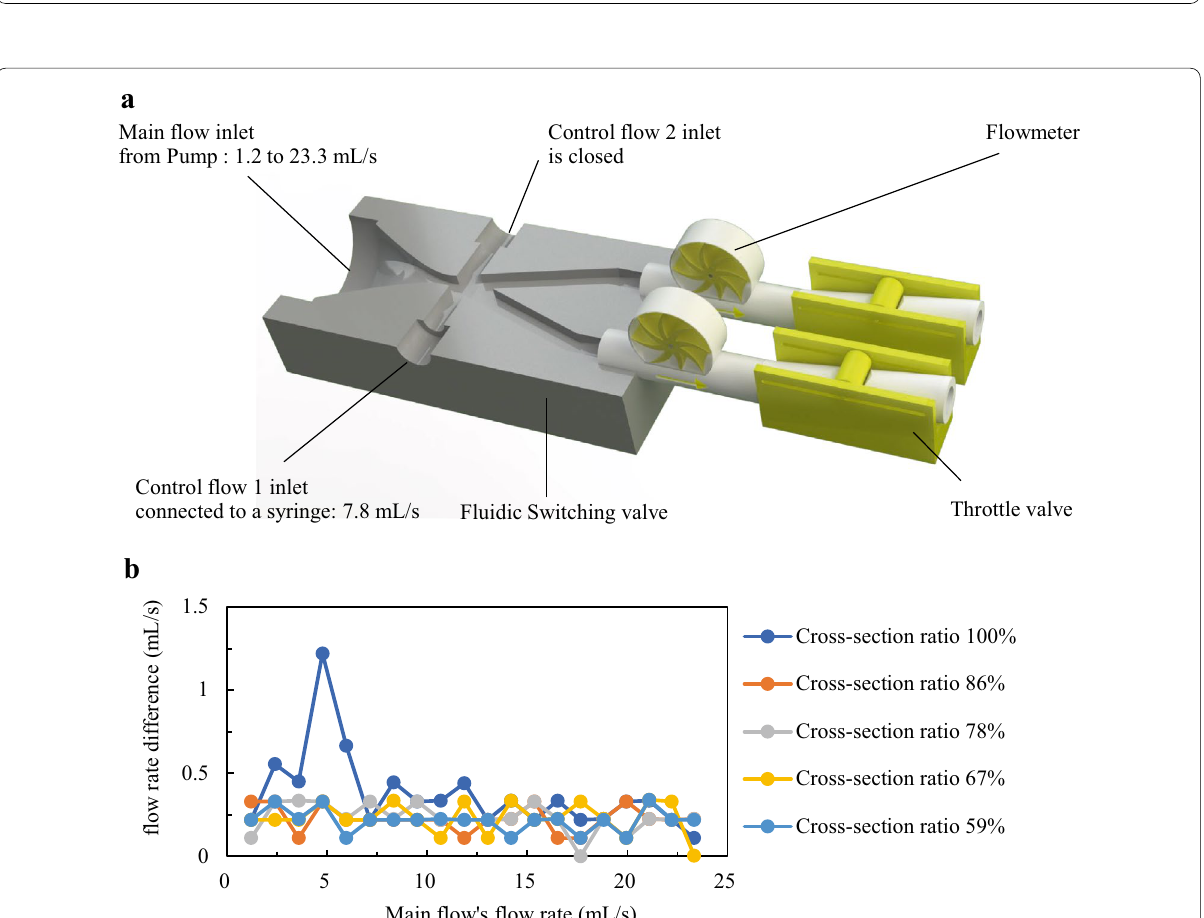
Fig. 5 The experiment for switching characterization. a The set up for the experiment. b the flow rate difference of the outlet 1 against outlet